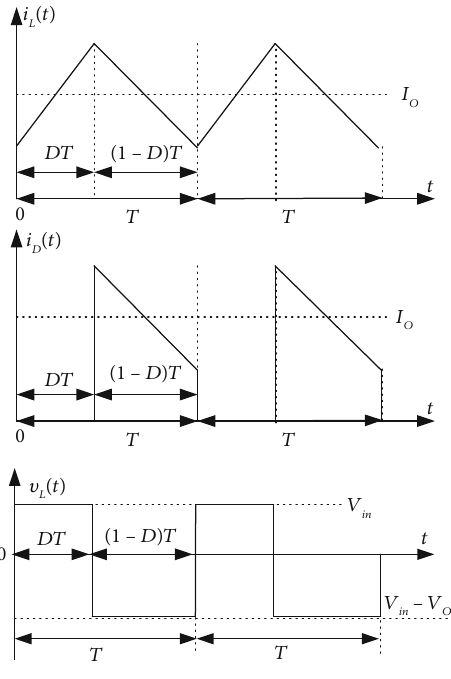
Figure 5: Boost converter waveforms at